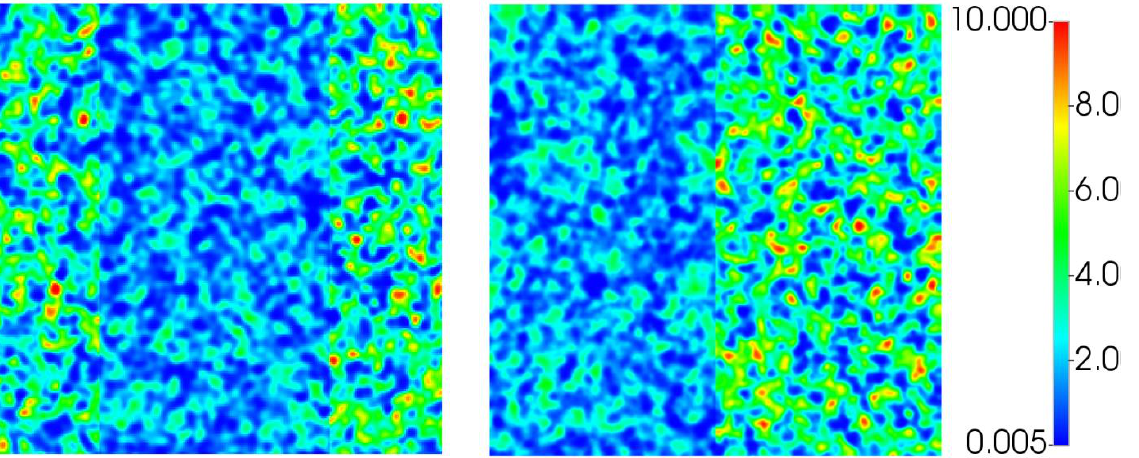
Figure 11. Structured permeability fields (D) used in simulation of the 412 mPa.s ( left ) and 616 mPa.s ( right ) cases.